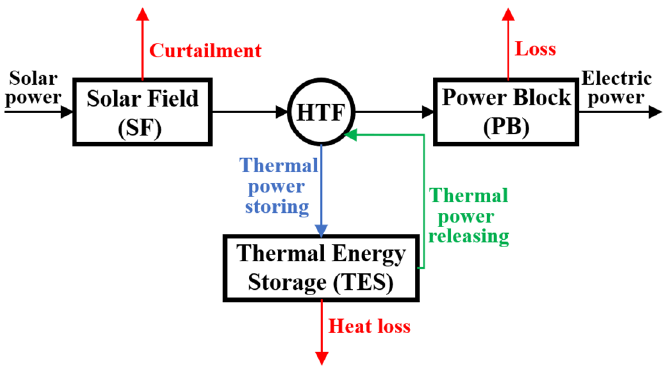
Figure 3. Simplified energy flow in the CSP unit with TES.